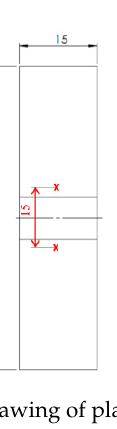
Figure 5. Drawing of shear test specimen.